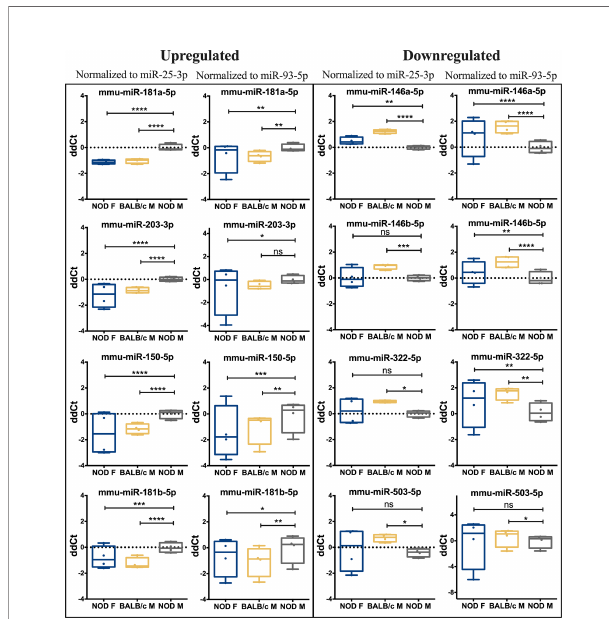
FIGURE 5 | qRT-PCR validation of miRNA hits in mice tears. In a separate cohort of age-matched mice, 13 miRNA hits from the sequencing data set were tested by qPCR to con fi rm the initial observation. Data was fi rst normalized for plate to plate variation using a spike-in RNA and then to two internal controls, miR-93-3p and miR-25-3p. Of the 13 original hits, 8 miRNA were con fi rmed as differentially expressed. Statistics were performed on average D Ct values; data are plotted as DD Ct. qPCR was performed with N=4 biological replicate samples, n=3 mice per sample, with 3 technical replicates per sample. (*p < 0.05,